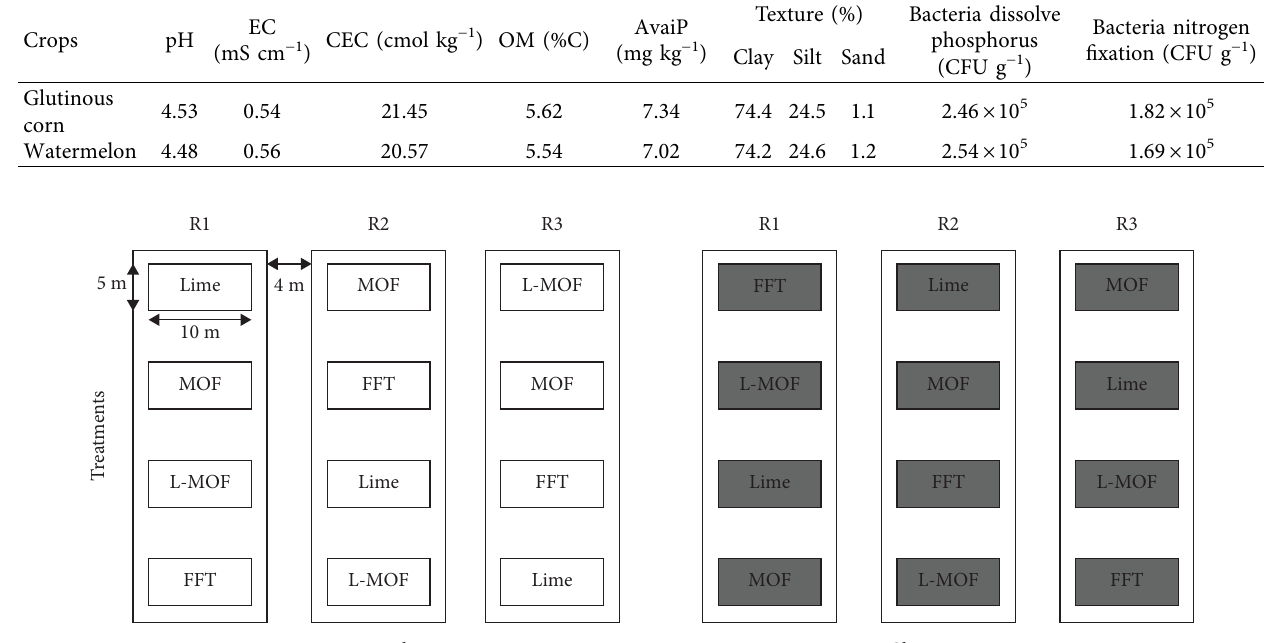
Table 1: Soil properties of the experiment site at the beginning season.